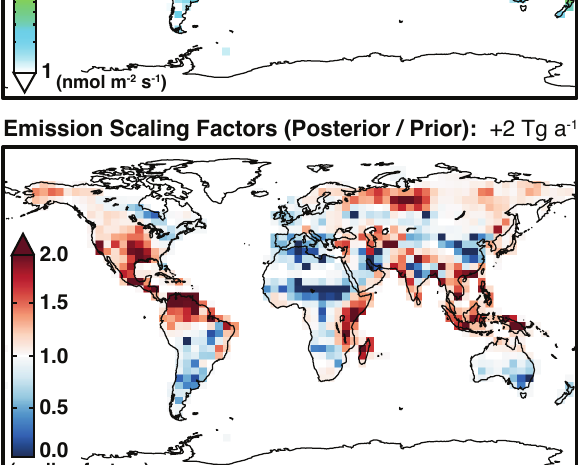
Figure 3. Optimization of methane emissions for 2009–2011 at 4 ◦ × 5 ◦ horizontal resolution using GOSAT observations. The pan- els show prior emissions, posterior emissions, and the ratio between the